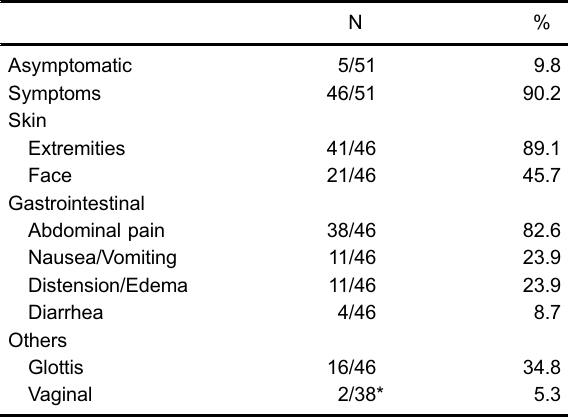
Table 1. Symptoms of patients with hereditary angioedema according to area of involvement.